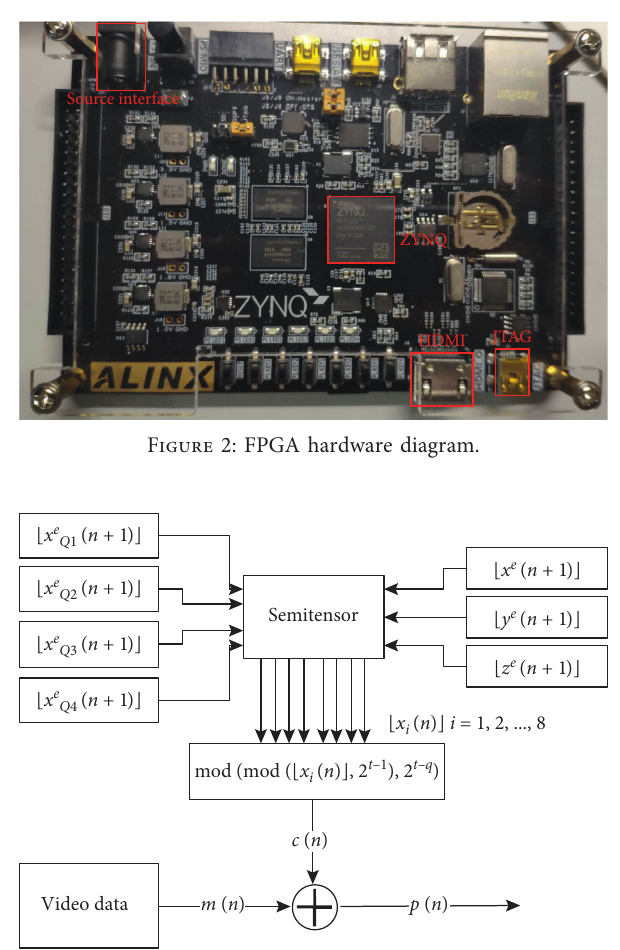
Figure 3: Block diagram of encryption